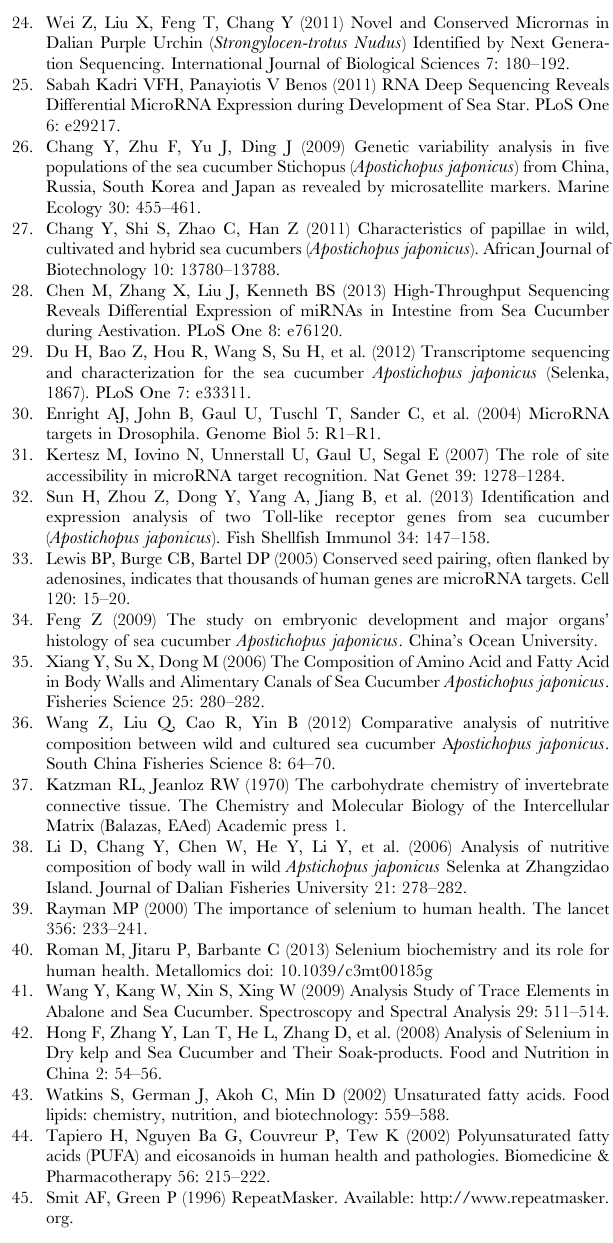
Table S3 Detailed pathways of miRNA target genes identified in the tube foot. (DOC) Table S4 Primers used in stem loop RT-PCR and qRT-